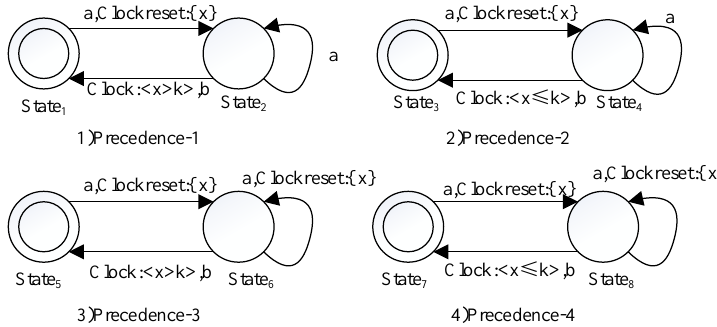
Figure 5. Property pattern of Precedence.